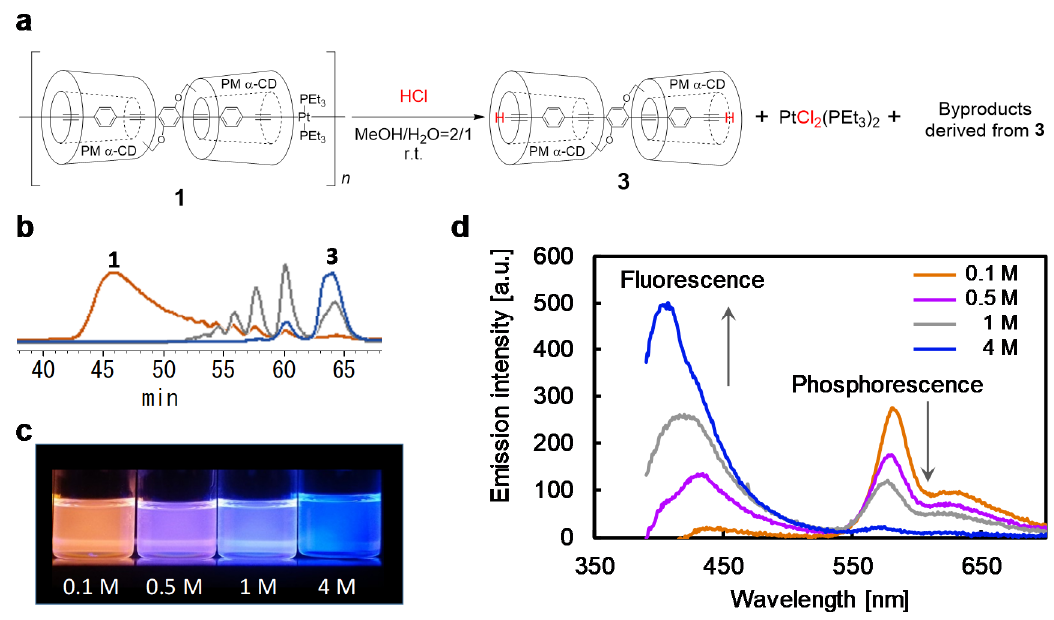
Figure 2. Depolymerizing experiments in the solution state: ( a ) Reaction of polymer 1 with HCl. ( b ) SEC analyses (detected at UV 380 nm) of the reaction products of polymer 1 before reaction (orange) and after reaction with 1 M HCl (gray) and 4 M HCl (blue) for 18 h. ( c ) Photographic images and ( d ) emission spectra of the reaction mixture of 1 by varying the concentration of HCl in ( c ), under deoxygenated conditions (excitation at 365 nm).